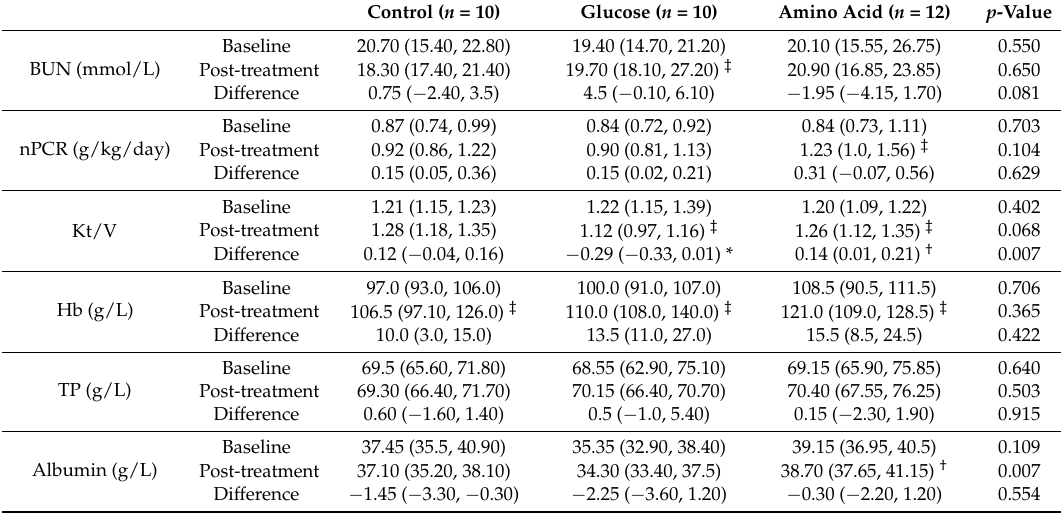
Table 3. Comparison of median energy intake and biochemical indices for the three treatment